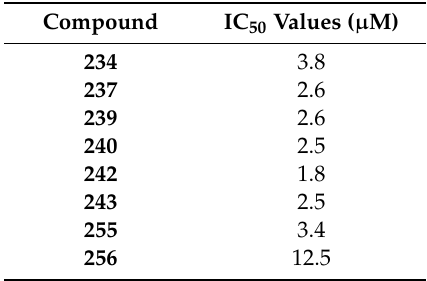
Table 33. IC 50 values in µ M of compounds 234 , 237 , 239 , 240 , 242 , 253 , 255 , and 256 against recombinant falcipain-2.